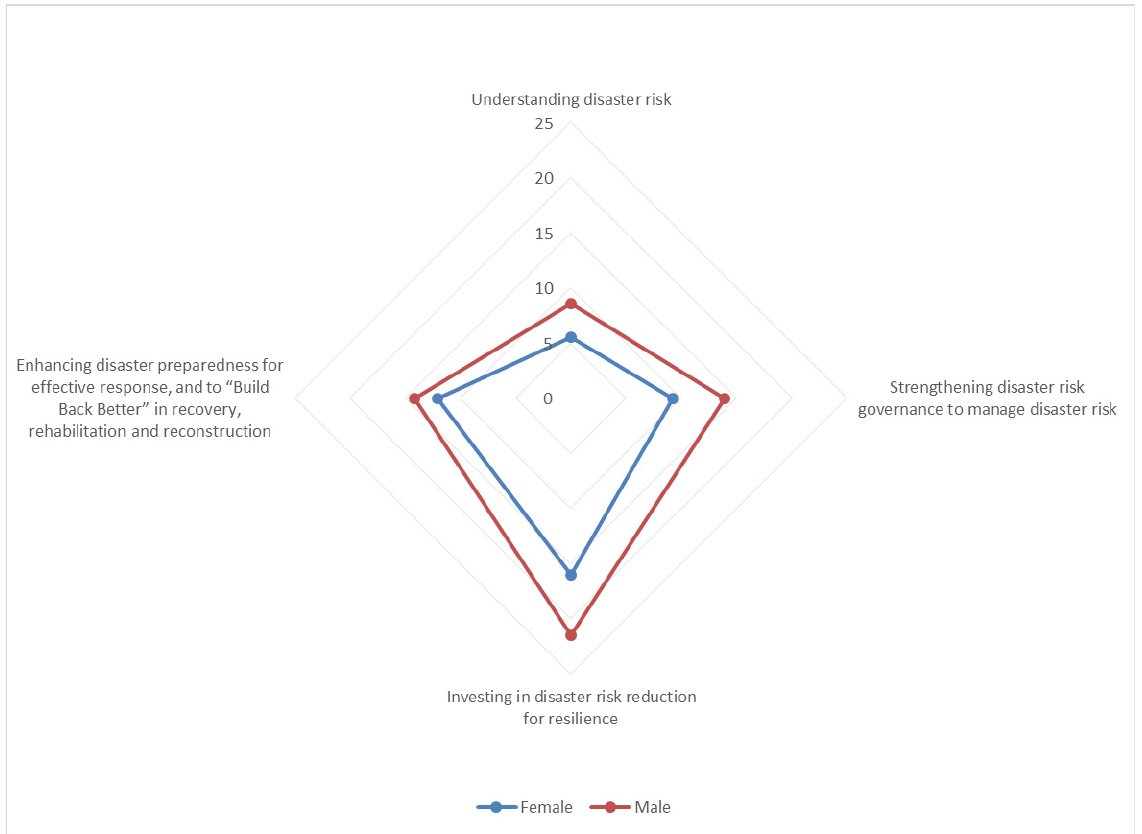
Figure 2. Community level of resilience (Based on priorities of SFDRR).